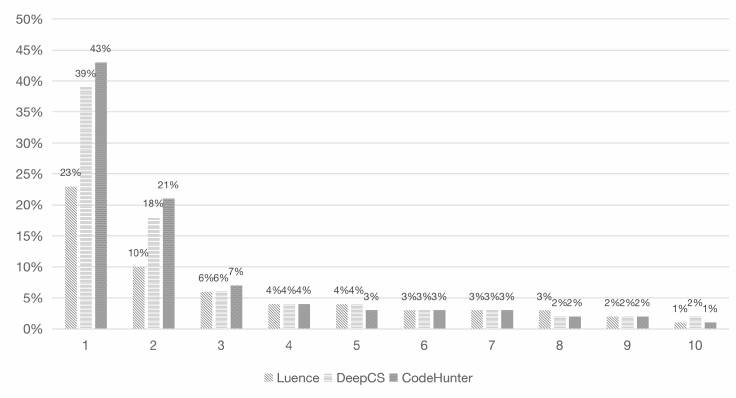
Figure 6. The distribution of Lucene, DeepCS, CodeHunter correct result.